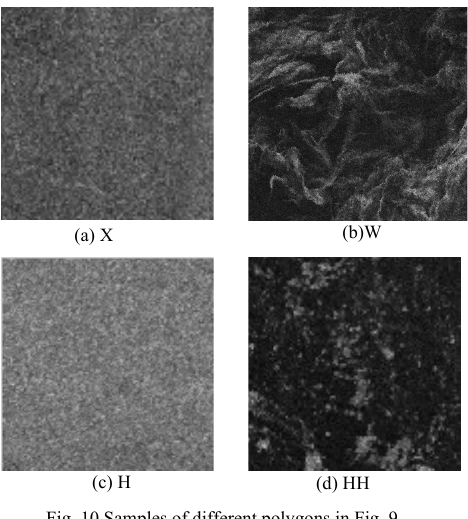
Fig. 10 Samples of different polygons in Fig.